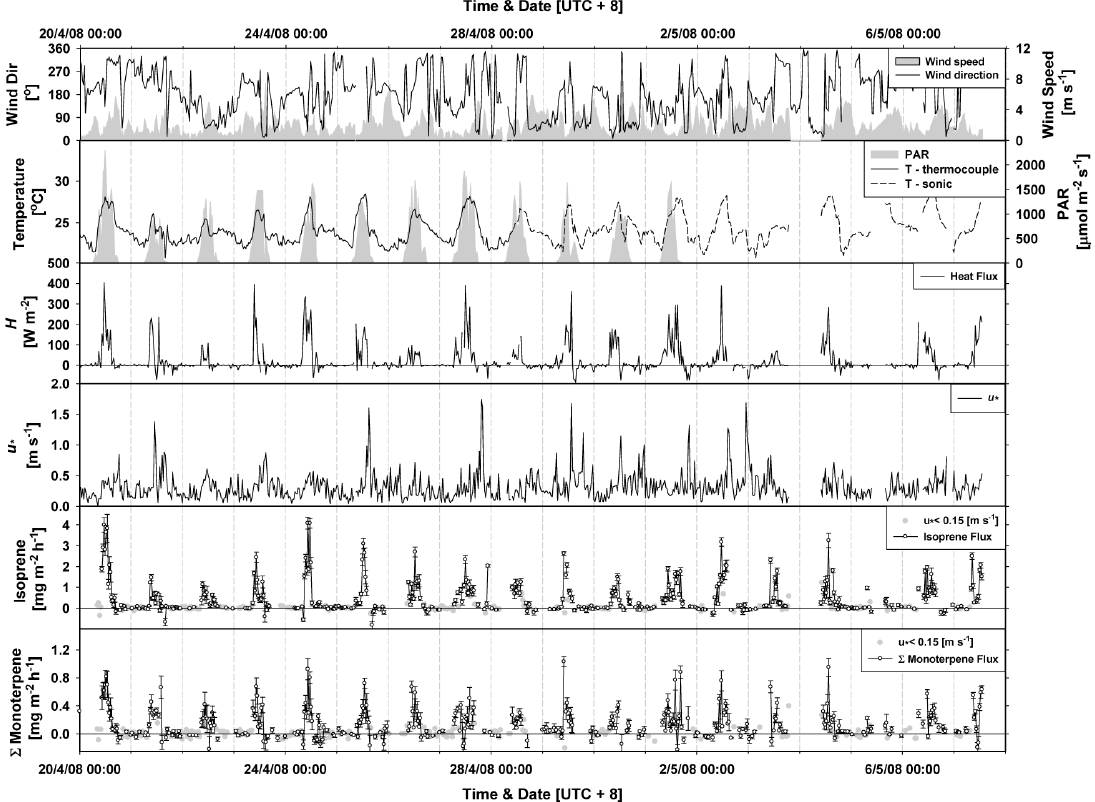
Fig. 6a. Summary of the meteorology and main VOC fluxes during the first intensive OP3 field campaign (OP3 – I) which took place during April and May, 2008. Wind speed and wind direction measurements were recorded by a senor (WXT-510 Weather Transmitter, Vaisala) situated at 75m on the GAW tower. Temperature was recorded at 30m by an aspirated thermocouple and sonic anemometer, PAR was measured from the roof of the GAW laboratory and sensible heat, friction velocity and VOC fluxes were all measured from the 75 m platform of the GAW tower. VOC flux data recorded during periods of low turbulence ( u ∗ < 0.15ms − 1 ) were rejected from the final analysis, but are shown here as grey